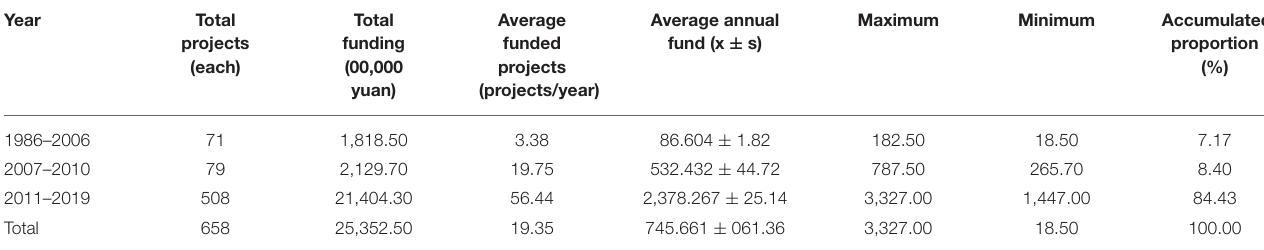
TABLE 1 | R&D input in rare diseases by NSFC and the changes.